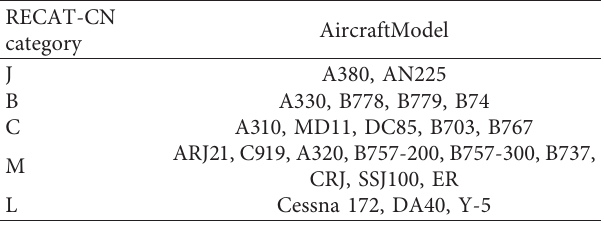
curve with θ , red dot as 2 ,r